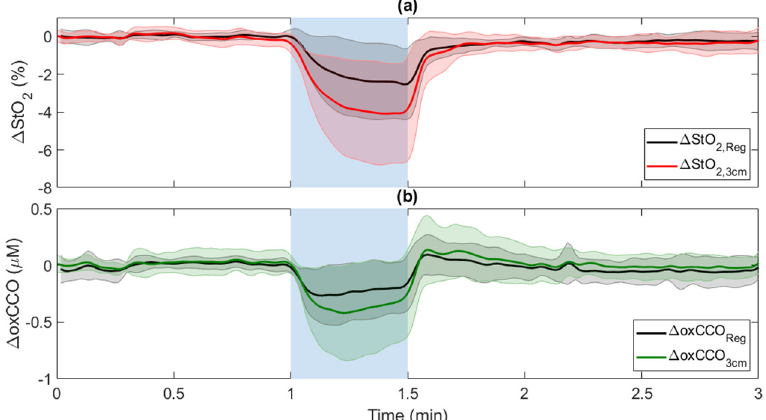
Figure 4. Regression analysis of ( a ) ΔStO 2 and ( b ) ΔoxCCO in response to ipsilateral 30-s CC (indicated by blue region between 1 and 1.5 min). In both cases, the time course measured at r SD = 1 cm was used as the regressor. Time courses were averaged across subjects, and shading surrounding each line represents the standard deviation.